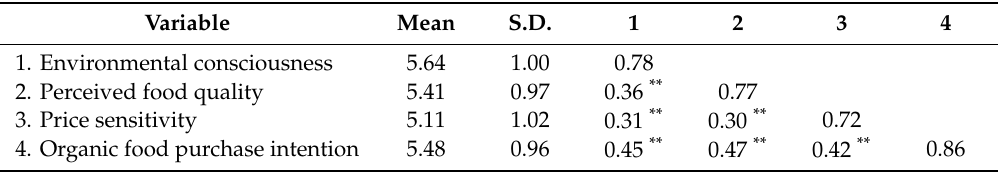
Table 3. Means, standard deviations, and Pearson